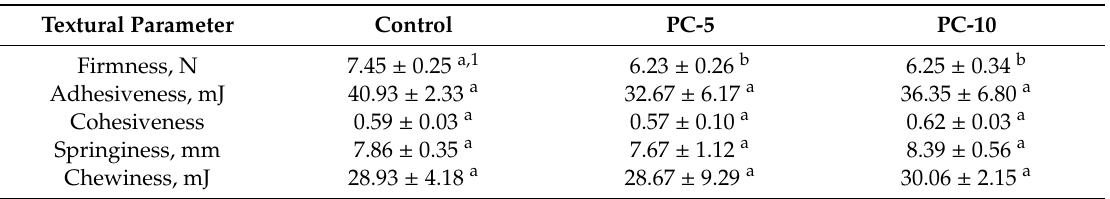
Table 2. Results of instrumental texture analysis of the pastry cream samples enriched with di ff